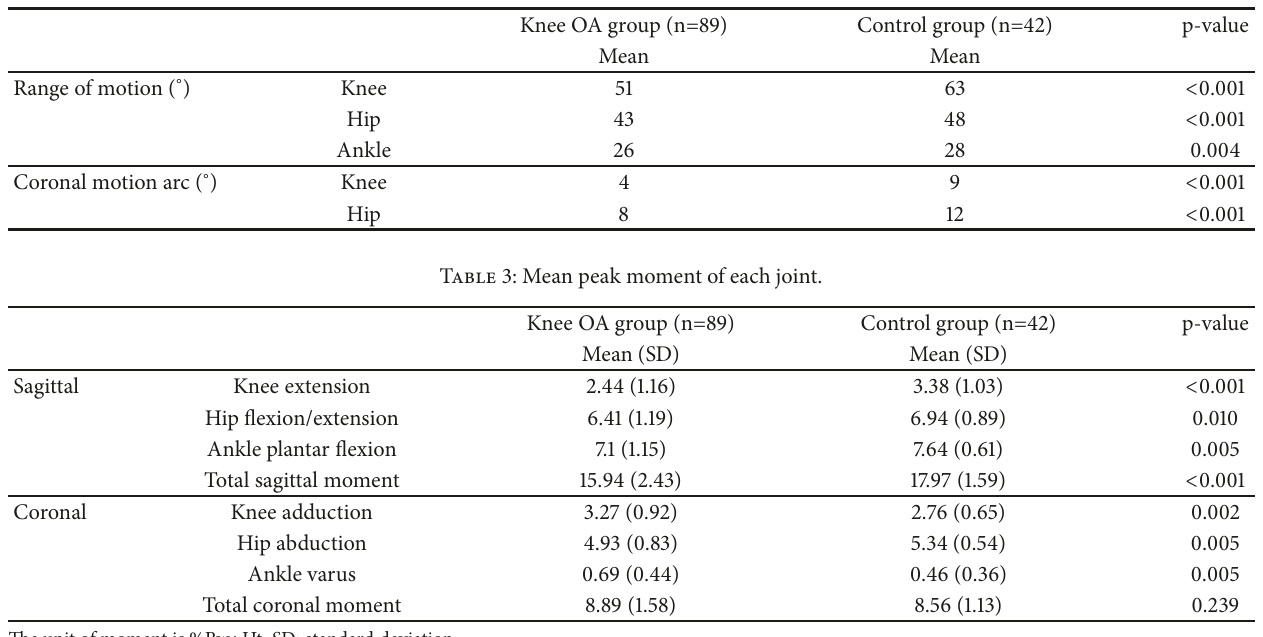
Table 2: Range of motion and coronal motion arc of each joint.